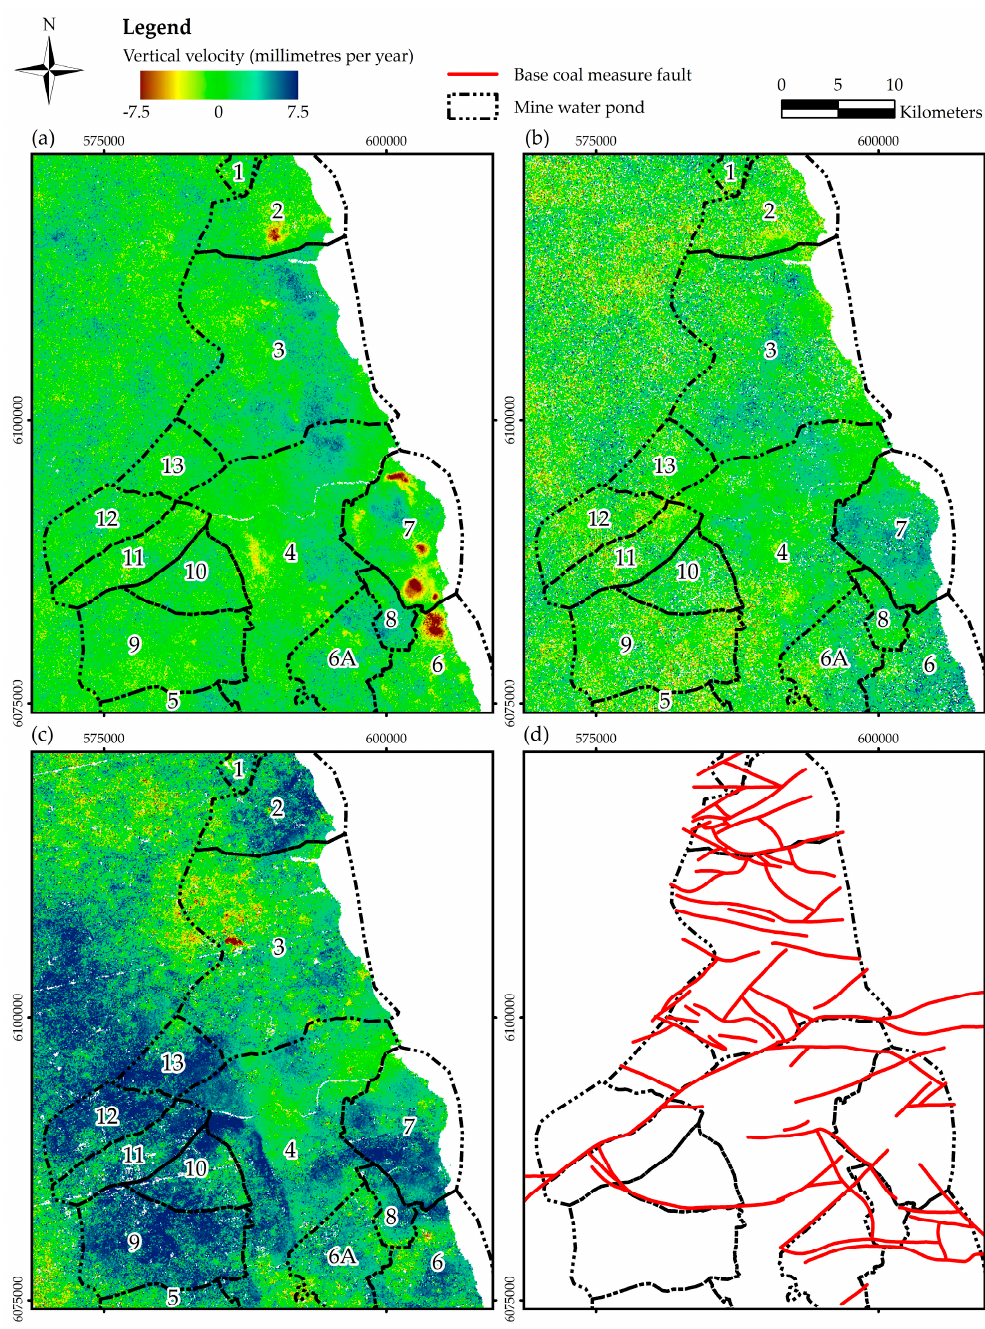
Figure 7. ISBAS vertical velocities (millimetres per year) with minewater ponds overlaid: ( a ) ERS ( b ) ENVISAT ( c ) Sentinel-1; ( d ) Minewater ponds and base coal measure